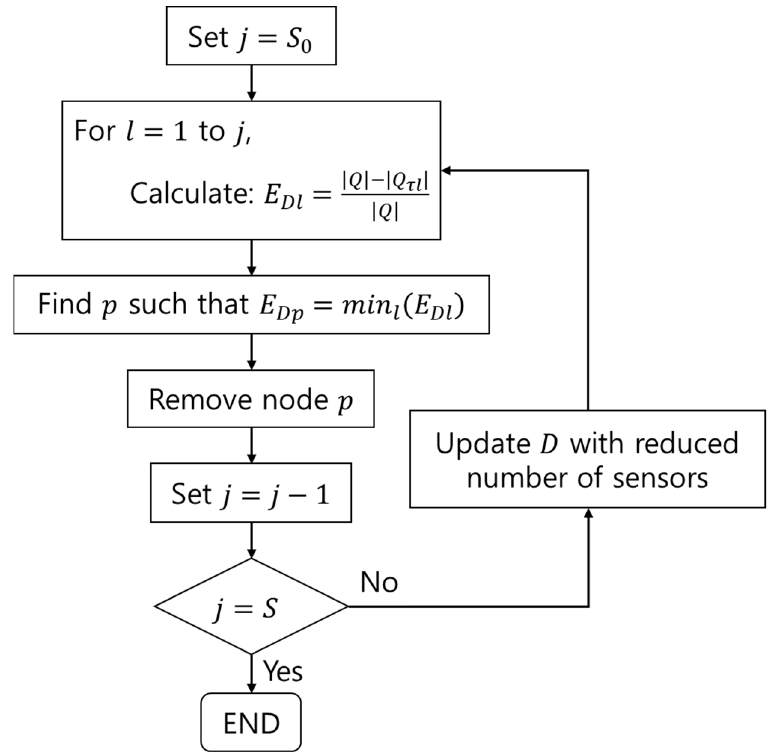
Figure 2. Process of